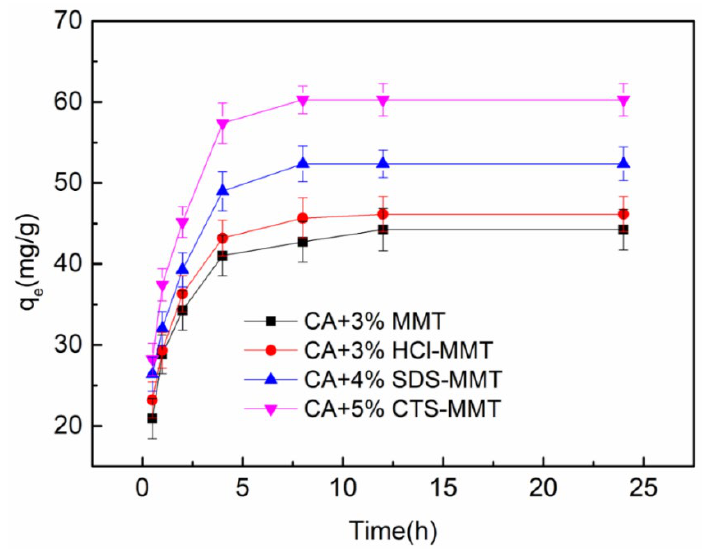
Figure 9. Relationship between adsorption capacity and adsorption time of various composite fiber membranes with pH 5 of Cu 2+ adsorption solution (100 mg/L).